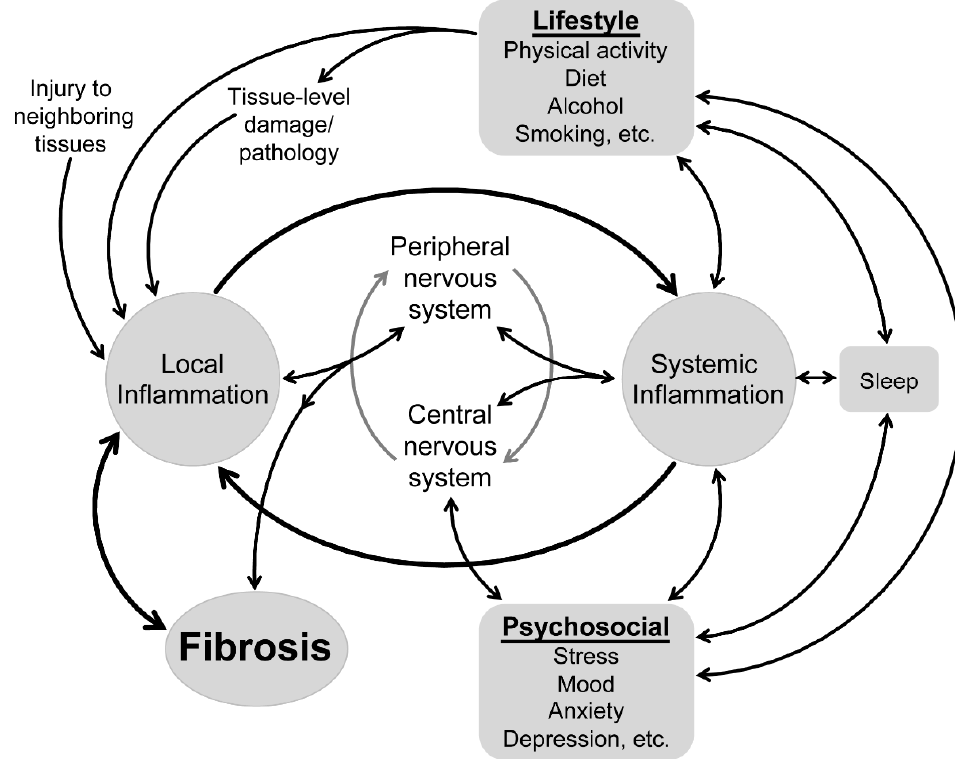
Figure 1. Conceptual model of the factors that impact tissue health in musculoskeletal